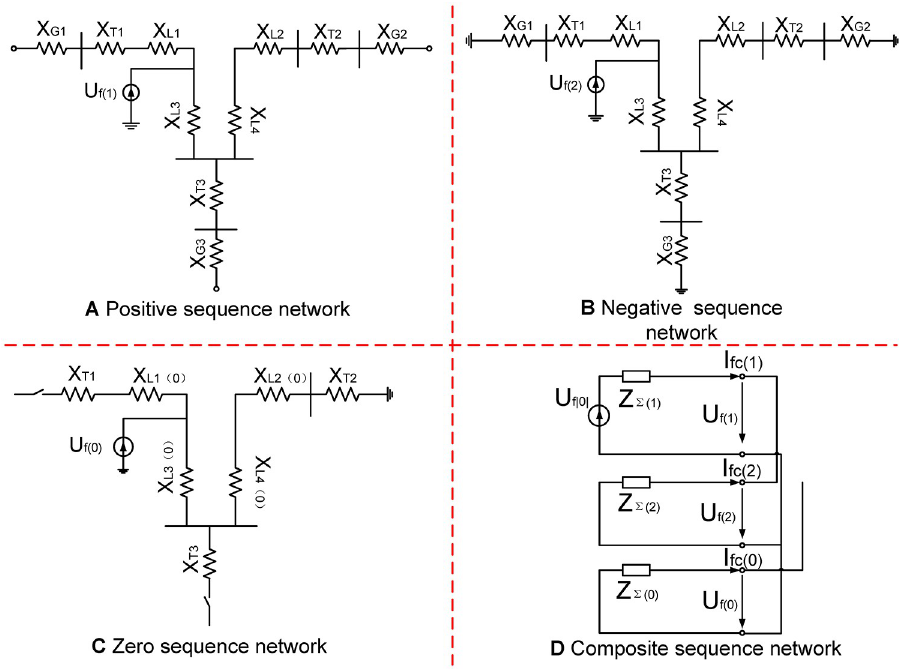
Fig 7. Three-sequence network diagram. (A) Positive sequence network (B) Negative sequence network (C) Zero sequence network (D) Composite sequence work.